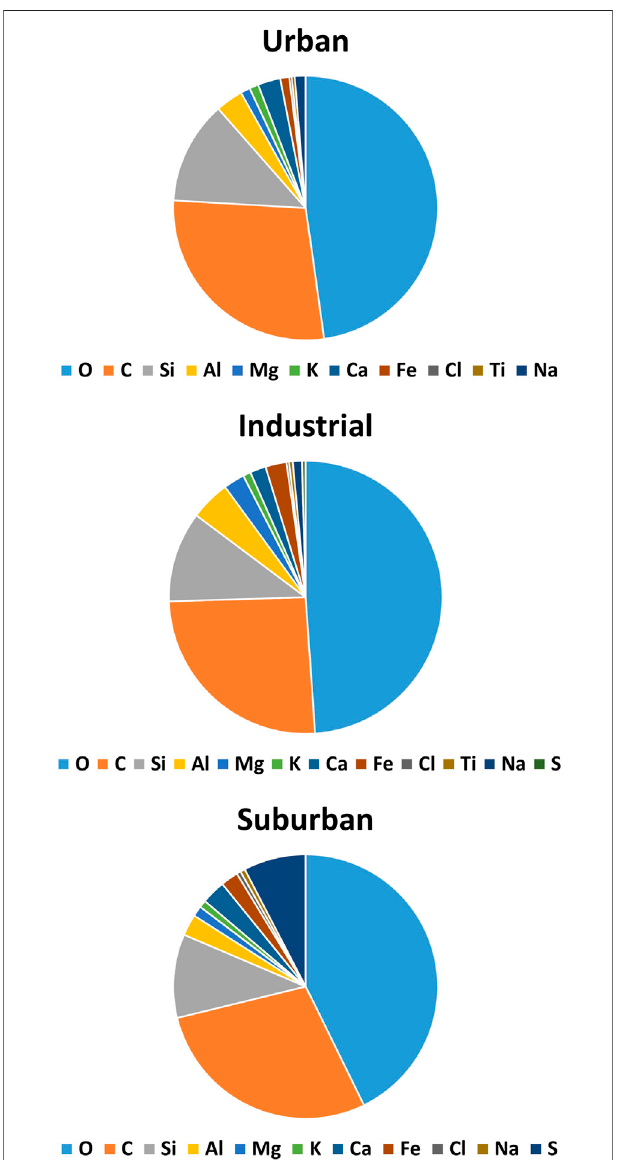
FIGURE 5 | Percentage of different elements in PM 10 in three locations.